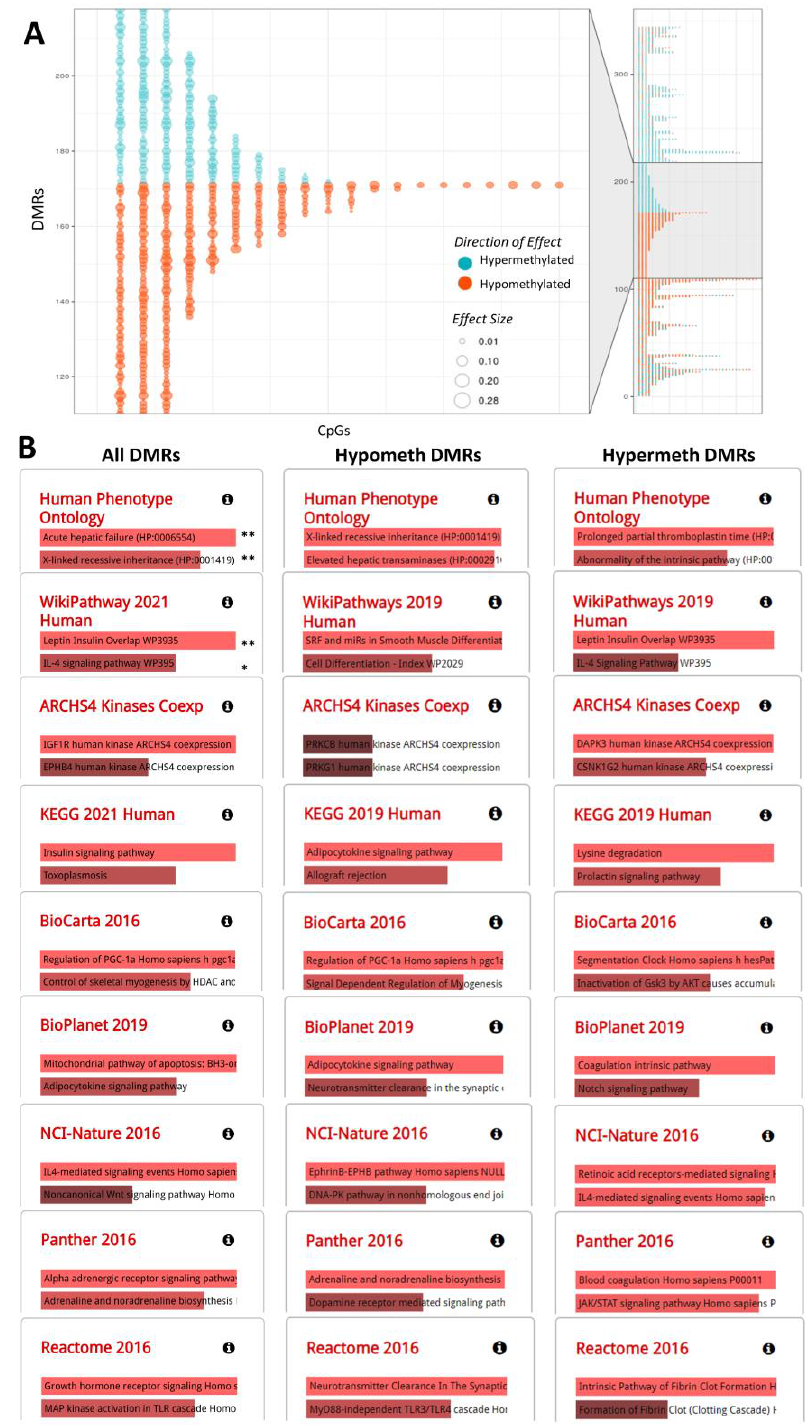
Figure 2. ( A ) DMRs obtained from the AF18 continuous model are represented on the y -axis and their constituent CpGs on the x -axis. Hyper- and hypo-methylated CpGs in relation to AF levels are shown in blue and orange circles, respectively, and the size of the circle is proportional to the effect size (being the regression coefficient). The middle zoomed cluster represents DMRs encom- passing three or more CpGs showing a 100% consistent direction of effect. ( B ) Ontology (first row) and pathway (other rows) analysis using EnrichR was performed on all DMRs (first column) and then stratified by hyper- and hypo-methylated DMRs (second and third columns,